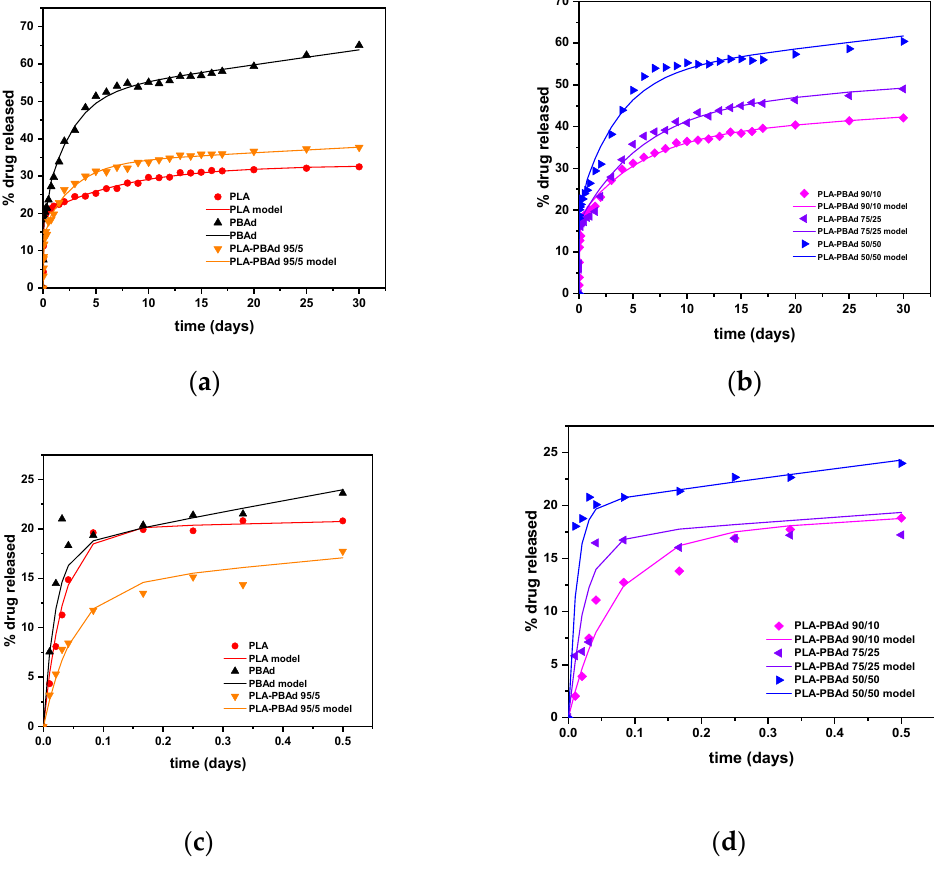
Figure 10. Comparison of experimental release data (symbols) to the mechanistic model-based Equation (9) (continuous lines). The presentation is made in two-time scales just for clarity: ( a , b ) 0–30 days and ( c , d ) 0–0.5 days.